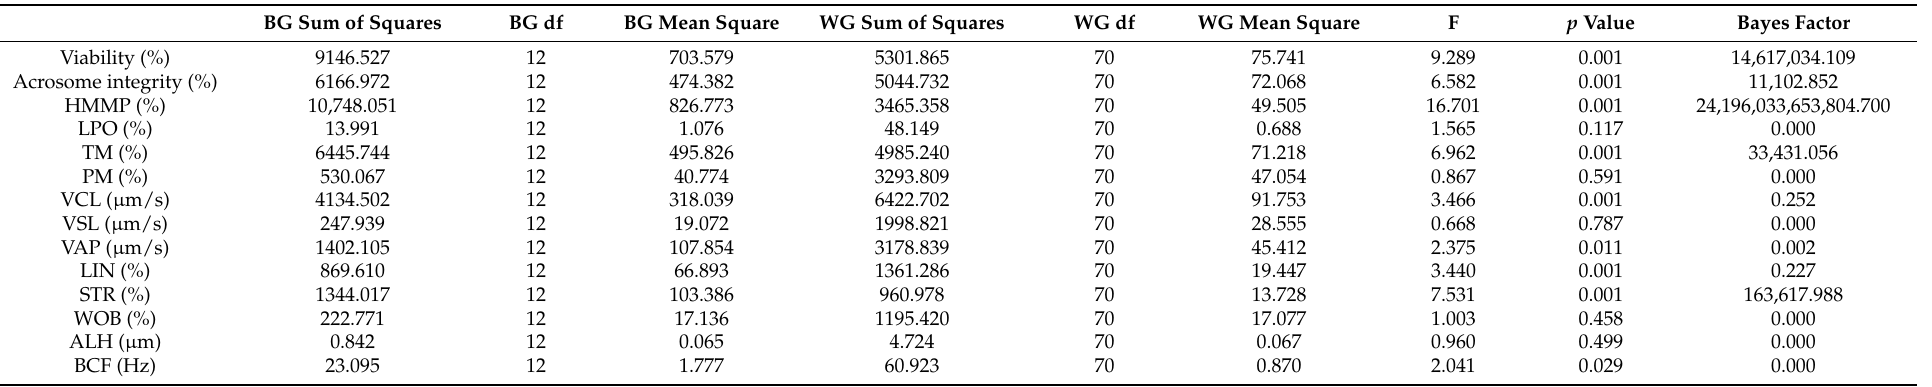
Table 3. Summary of the outputs of Bayesian inference ANOVA to detect differences in the mean of sperm parameters across the different concentrations of HT, DHPG, and MIX antioxidants. BG Sum of